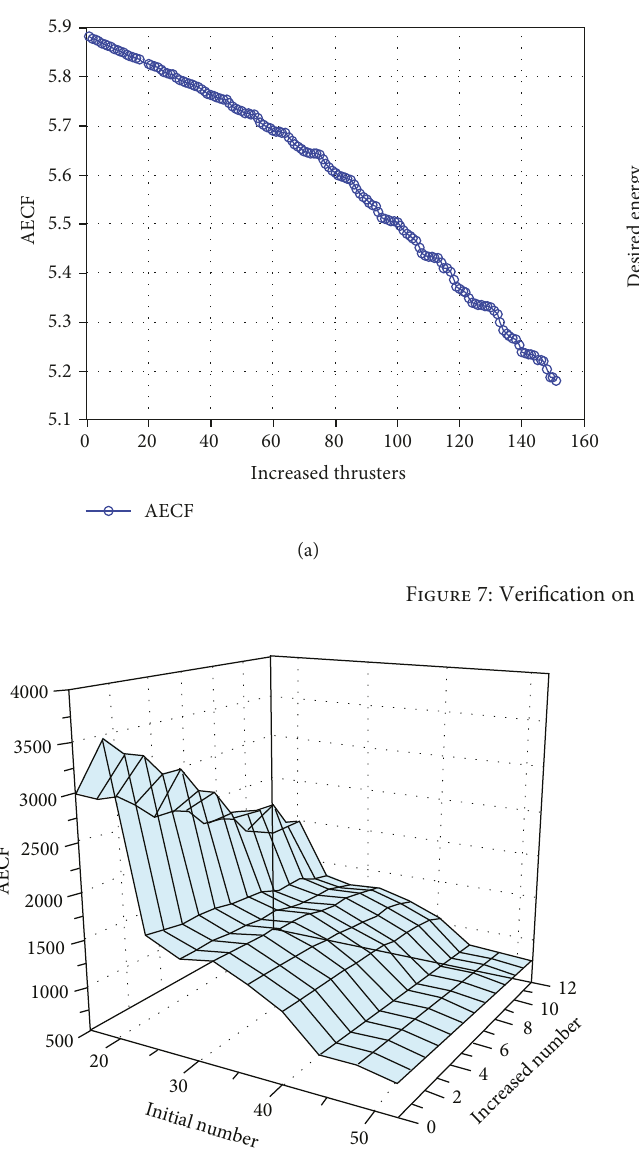
Figure 8: AECF varies with di ff erent control expectations and quantities of optimized thrusters.